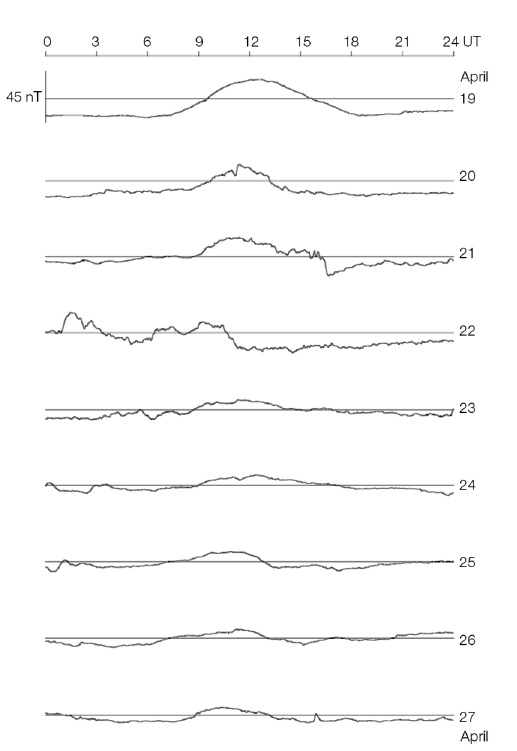
Fig. 4. Diurnal field variations recorded in Univer- sal Time (UT) at the Güímar geomagnetic observato- ry from 19-27 April